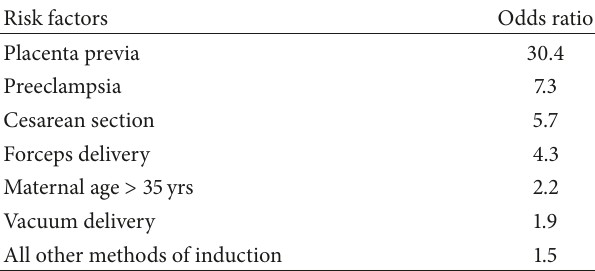
Table 3: Risk factors and odd ratios for AFE. Abenhaim et